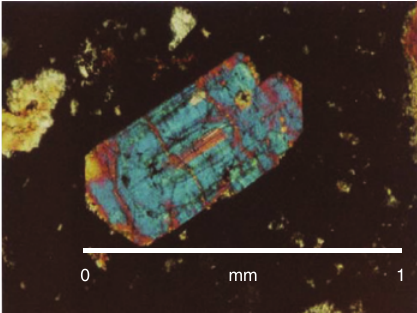
Figure 4 Pyroxene feno crystals within the Isparta-Karakaya pumice.